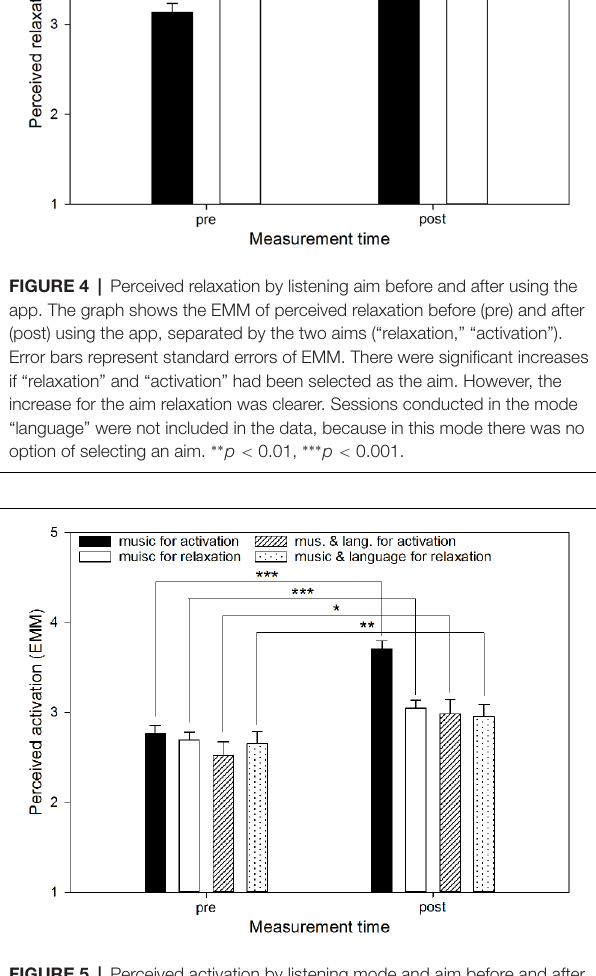
FIGURE 5 | Perceived activation by listening mode and aim before and after using the app. The graph shows the EMM of perceived activation before (pre) and after (post) using the app, separated by the modes “music” and “music and language” as well as the two aims (“relaxation,” “activation”). Error bars represent standard errors of EMM. All of the combinations of aim and mode led to significant increases in perceived activation, yet the increase was most marked if music had been listened to for the aim of activation. Sessions conducted in the mode “language” were not included in the data, because in this mode there was no option of selecting an aim. ∗ p < 0.05, ∗∗ p < 0.01, ∗∗∗ p <